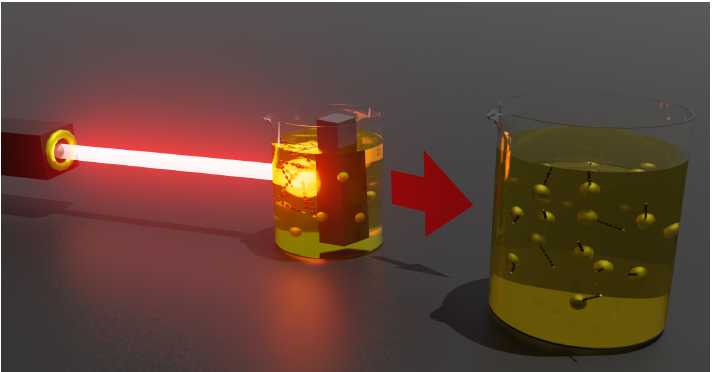
Figure 2. A representation of the PLAL procedure to synthesize the nanohybrid Ag@LCCs system. By the weight difference of the Ag and graphite targets before and after the